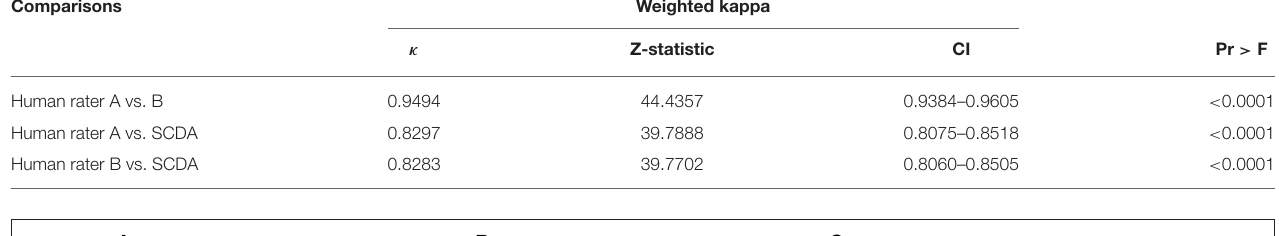
TABLE 1 | Agreement of two independent raters and SCDA according to Cohen’s weighted kappa and associated 95% confidence levels (CI).